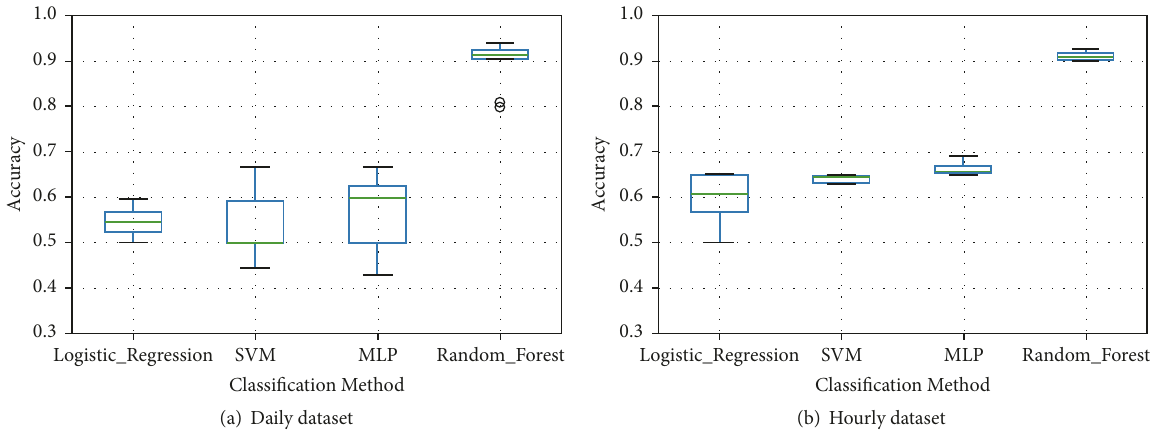
Figure 6: Performance result distributions in terms of accuracy.